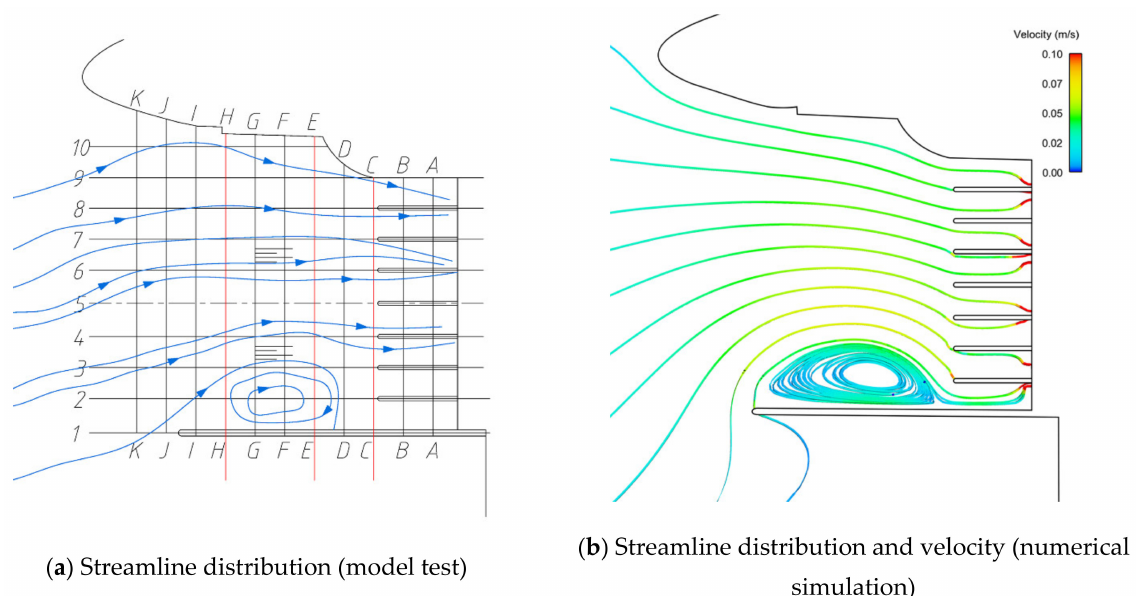
Figure 14. Plan 1 (design operating water level).